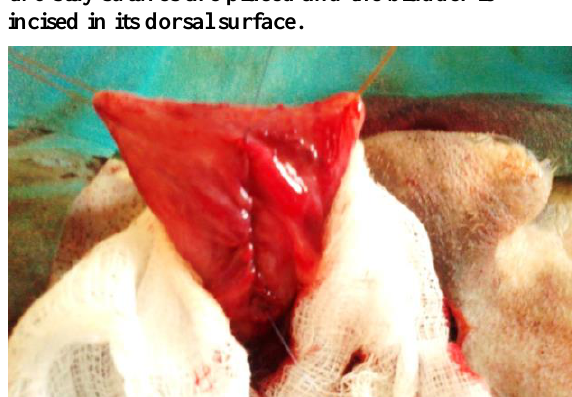
Figure, 3: In the first group, the bladder incision is closed by inverting suture (Lambert and Cushing)